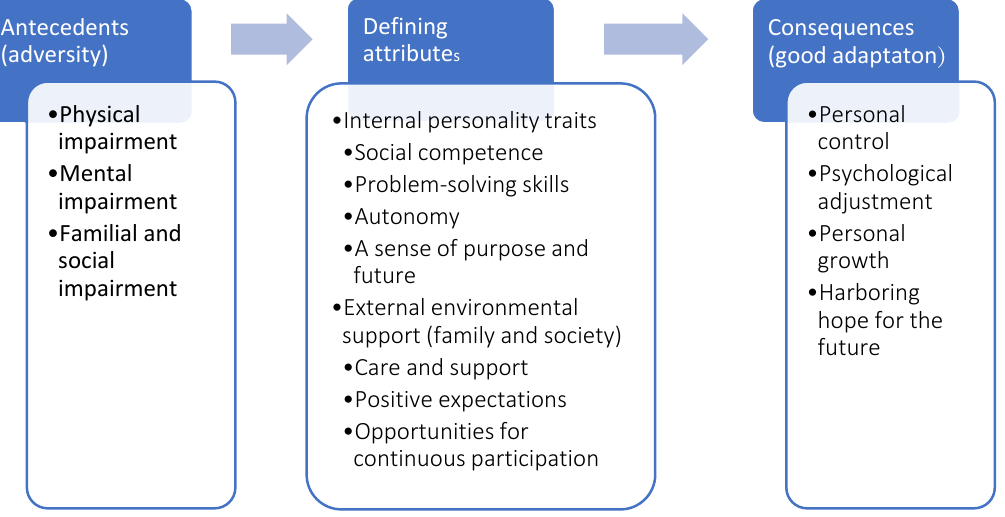
Figure 3. Conceptual model of resilience in stroke patients.